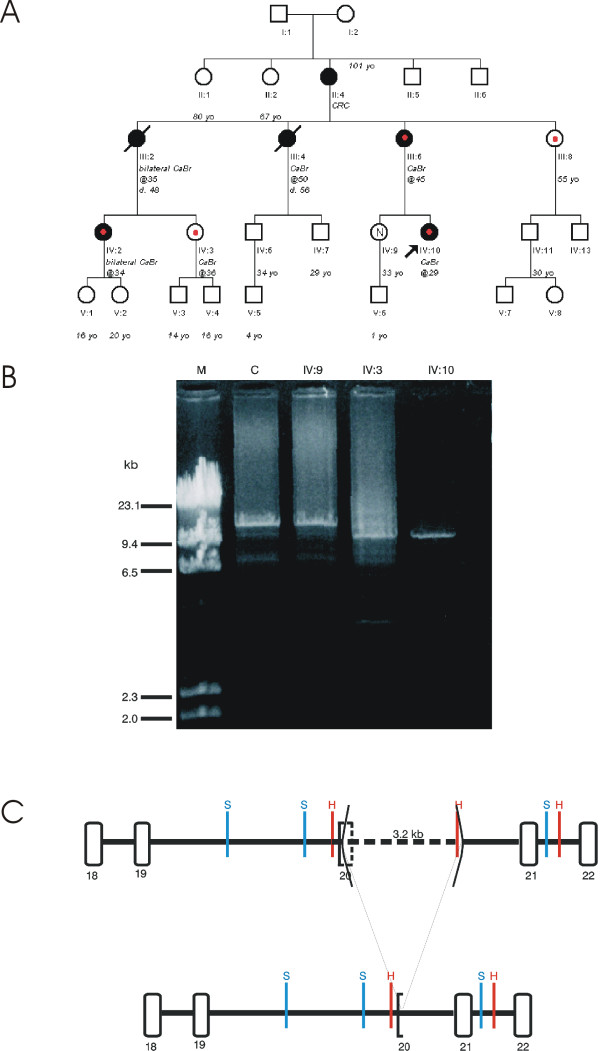
Family D in whom deletion of exon 20 of the BRCA1 gene was detected. a. Pedigree of family D. Black symbols indicate individuals with cancer. The proband is indicated by an arrow. A red circle inside a symbol indicates individuals found to carry the mutation. (CaBr=breast cancer, CRC=colorectal cancer d.=age of death, N=individual tested for the family mutation and was found to be of normal genotype). b. Long PCR of DNA from three individuals in family D. (M=molecular size marker (λ/HindIII, New England Biolabs, U.S.A.), C=normal control, numbers denote the identifier in the pedigree). c. Schematic representation (not to scale) of the fragment of BRCA1 gene amplified by Long PCR showing the position of exons, restriction endonuclease cleavage sites and the deletion. Empty boxes indicate exons. Vertical colored bars indicate restriction sites: blue (S) = SmaI. Red (H) = HindIII.